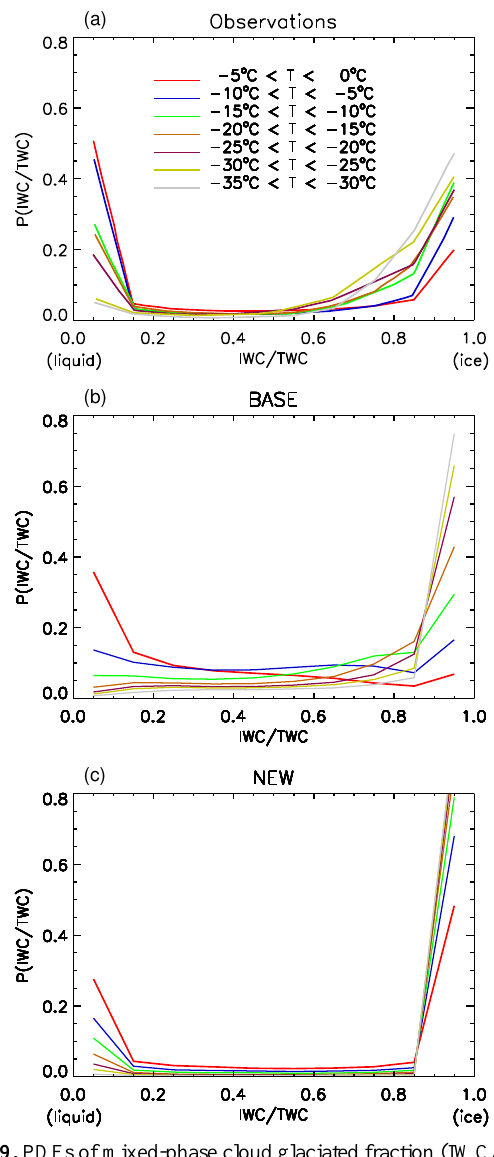
Fig. 9. PDFs of mixed-phase cloud glaciated fraction (IWC/TWC), where total stratiform water content TWC=LWC + IWC, for differ- ent temperature intervals compared to observations from Korolev et al. (2003). For the NEW scheme, TWC includes diagnosed rain and snow. Observations are representative of a horizontal scale on the order of